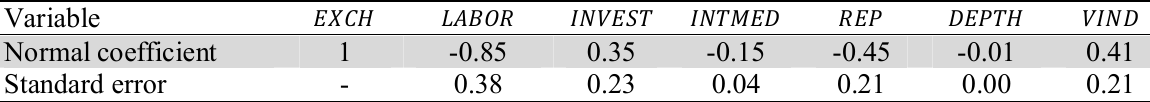
The summary of regression analysis